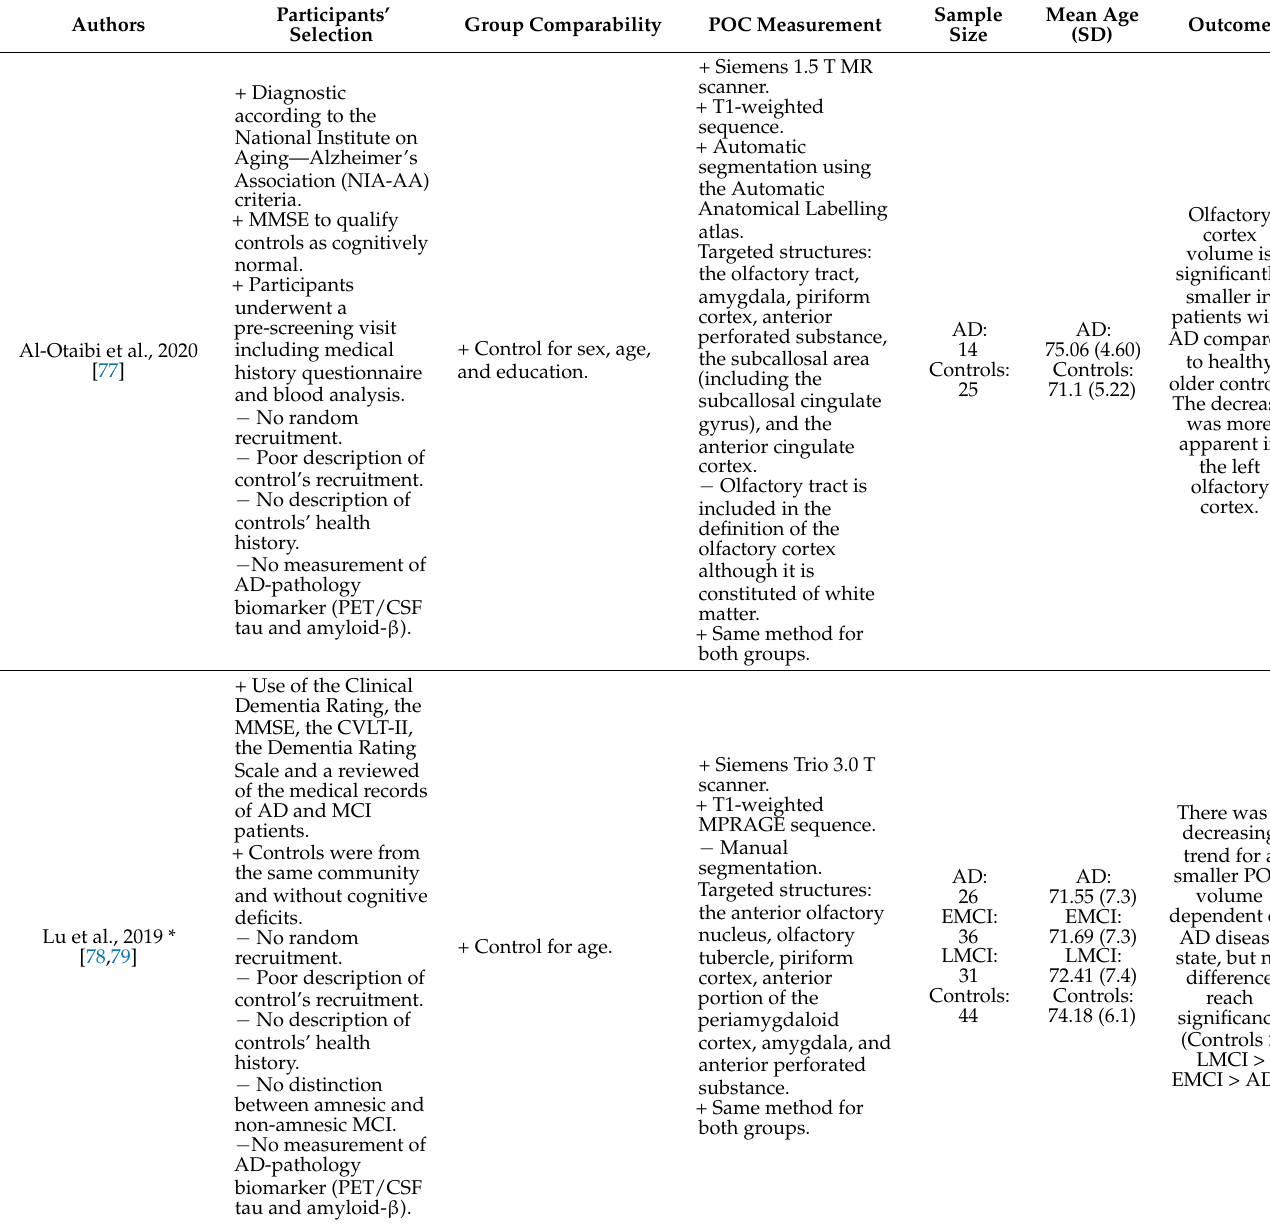
Table 3. Characteristics of studies included in the POC systematic